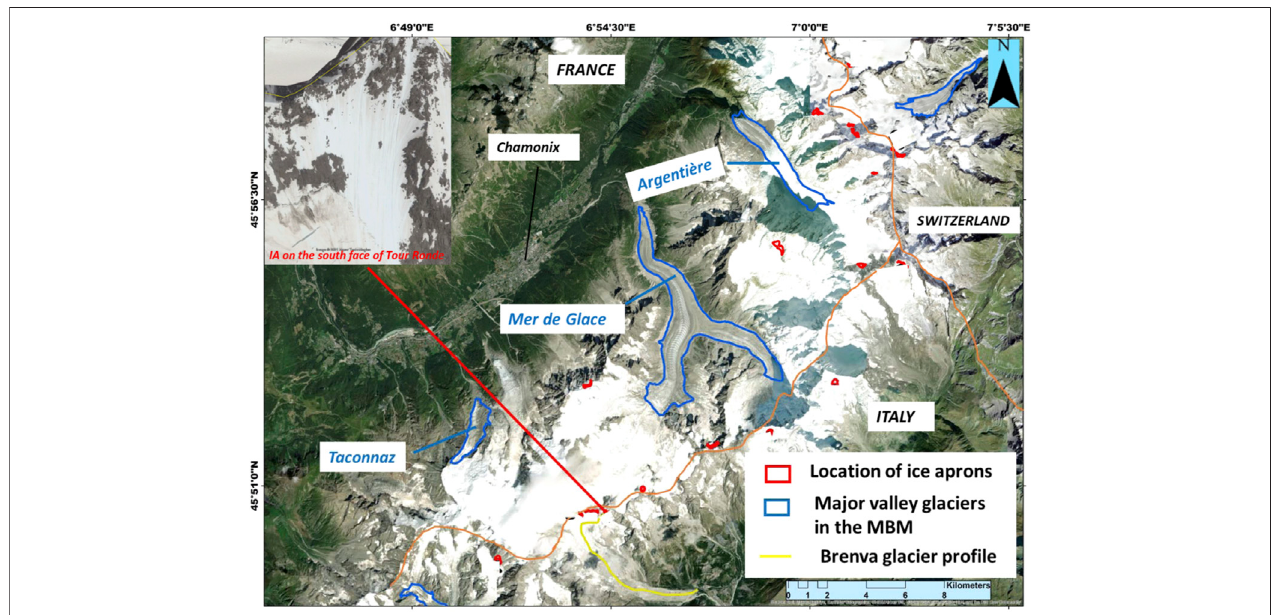
FIGURE 3 | The study area, Mont-Blanc massif. The base image shown is taken from ArcGIS World Imagery database.